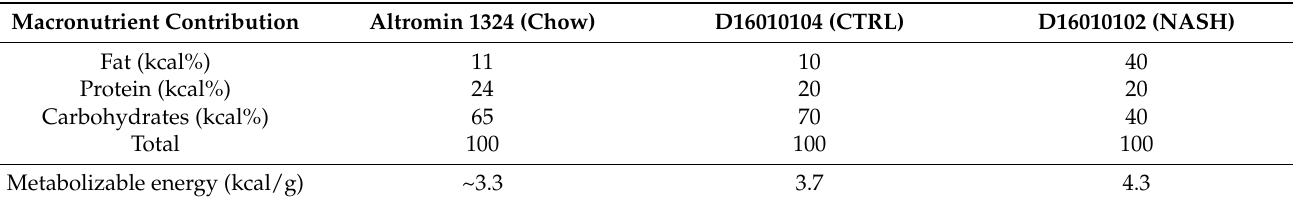
Table 1. Composition of the chow, CTRL and NASH diets used in the study